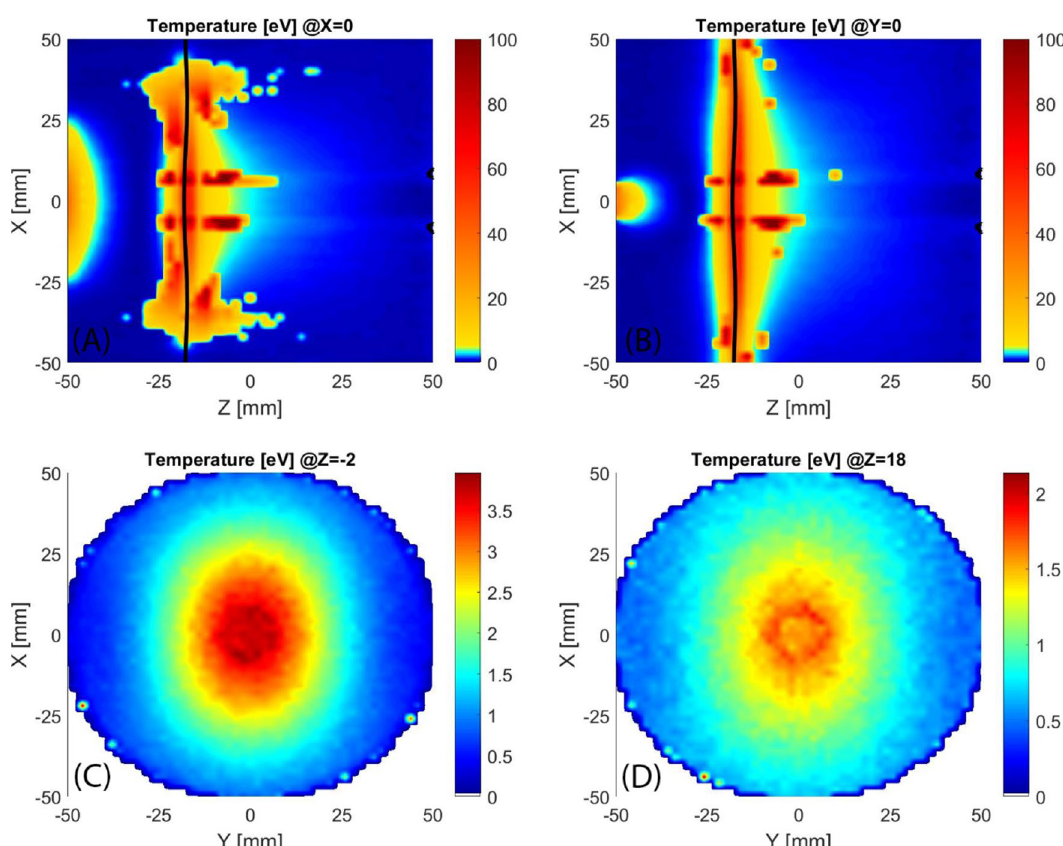
Figure 16. Longitudinal sections ( A , B ) and transversal sections ( C , D ) of evaluated electron temperature spatial distribution, black lines mark the ECR